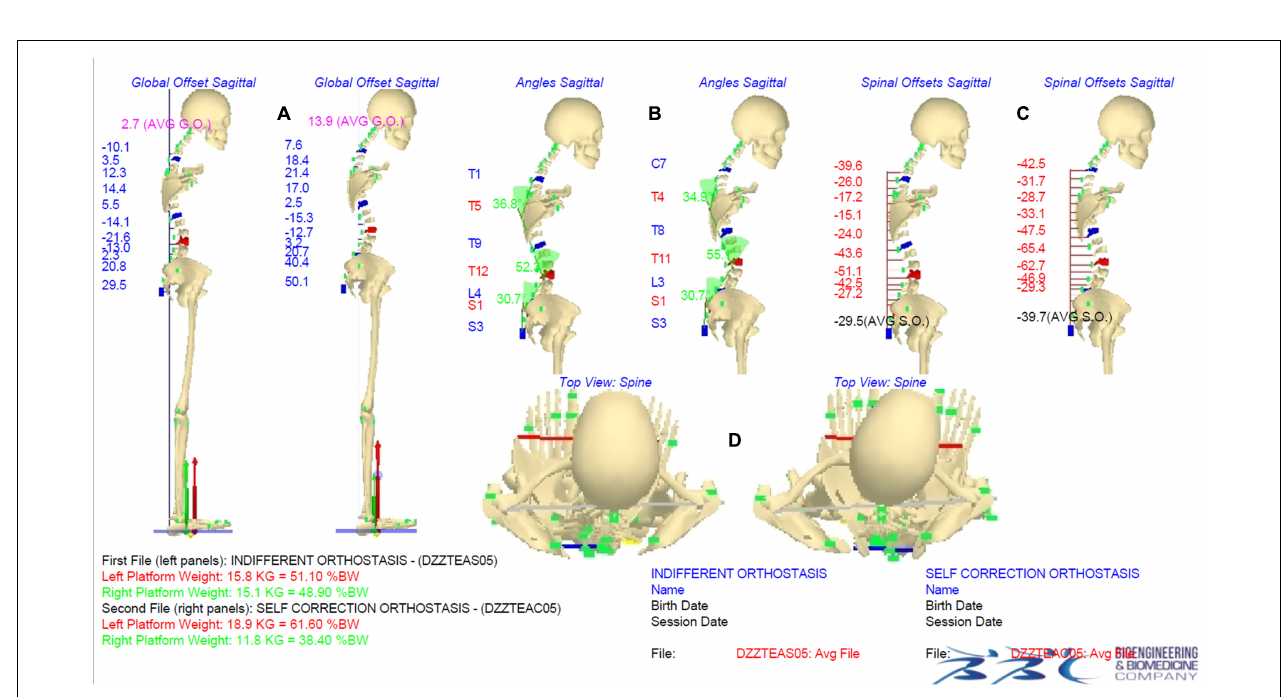
FIGURE 3 | Indifferent orthostasis (IO) vs. instinctive self-correction (ISCO) maneuver comparison graphical report. Panels (A–C) show the comparison IO (left side) vs. ISCO (right side) in the sagittal plane of averaged global offsets (AGO-SG), thoracic kyphosis and lumbar lordosis angle values, and averaged spinal offsets (ASO-SG), respectively. Panel (D) shows comparison IO (left side) vs. ISCO (right side) of rotations in the horizontal plane (head, shoulder girdle/pelvis, feet positions). Underfoot loads are represented by vertical forces vectors (red vector on the left side, green vector on the right side) graphically showing the | (cid:49) UL|